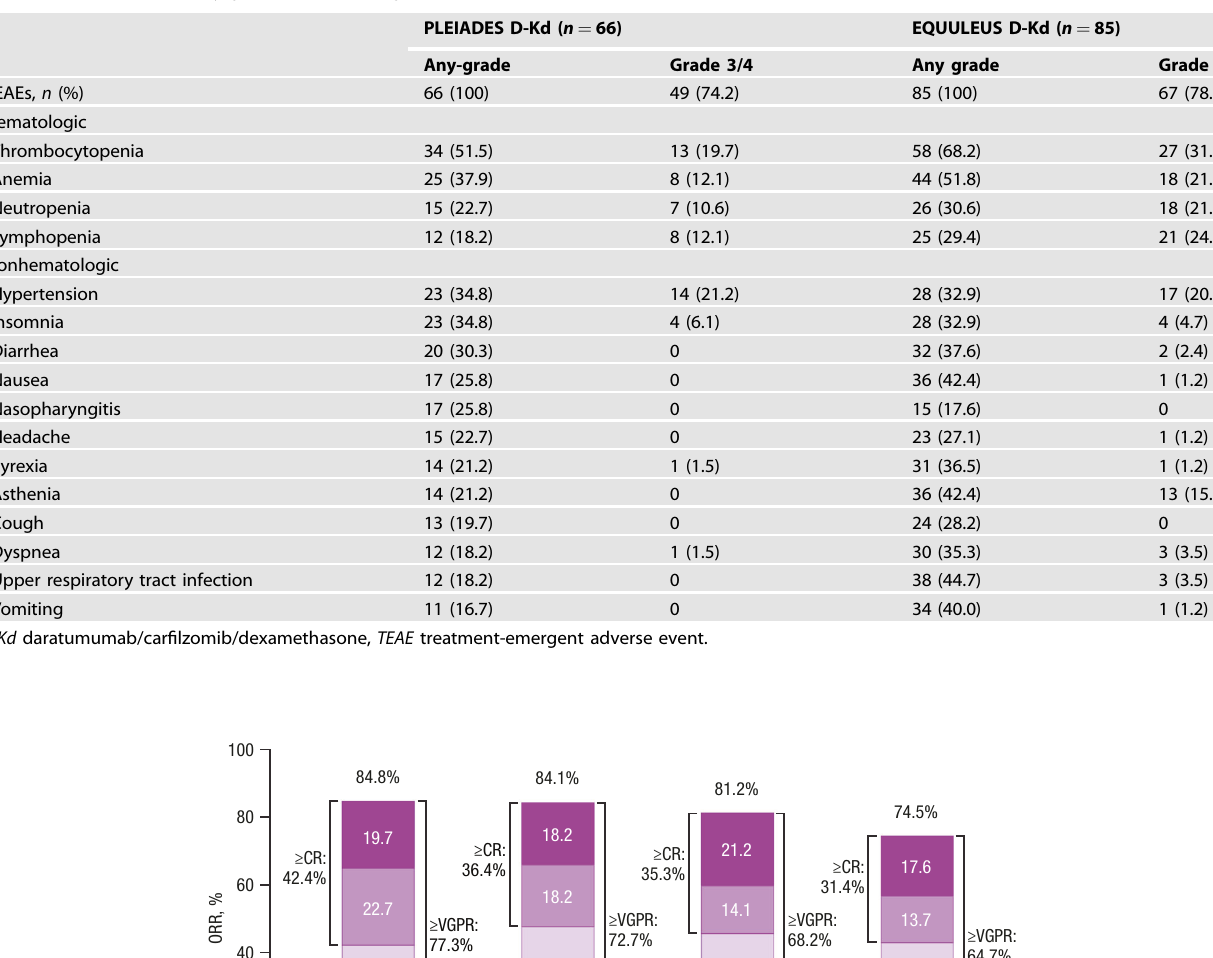
Table 1. Most common any-grade ( ≥ 25%) and grade 3/4 ( ≥ 5%) TEAEs with D-Kd in the PLEIADES and EQUULEUS studies.